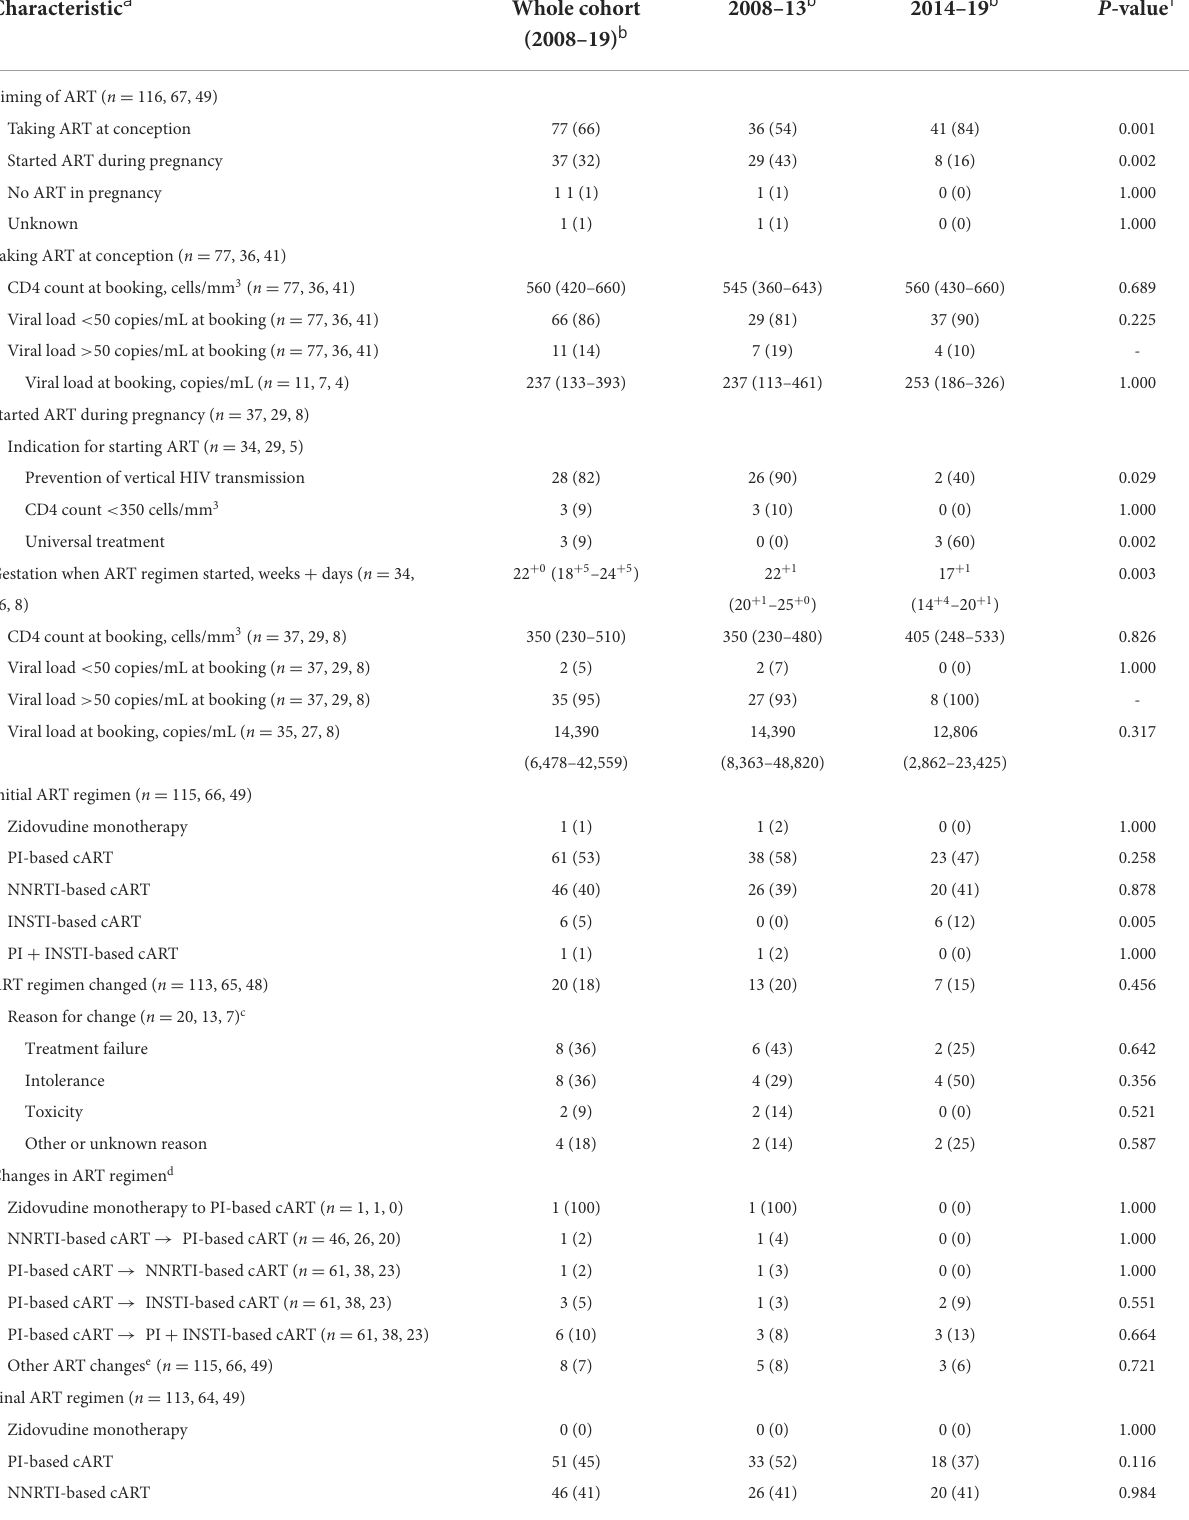
TABLE 3 HIV and antiretroviral therapy